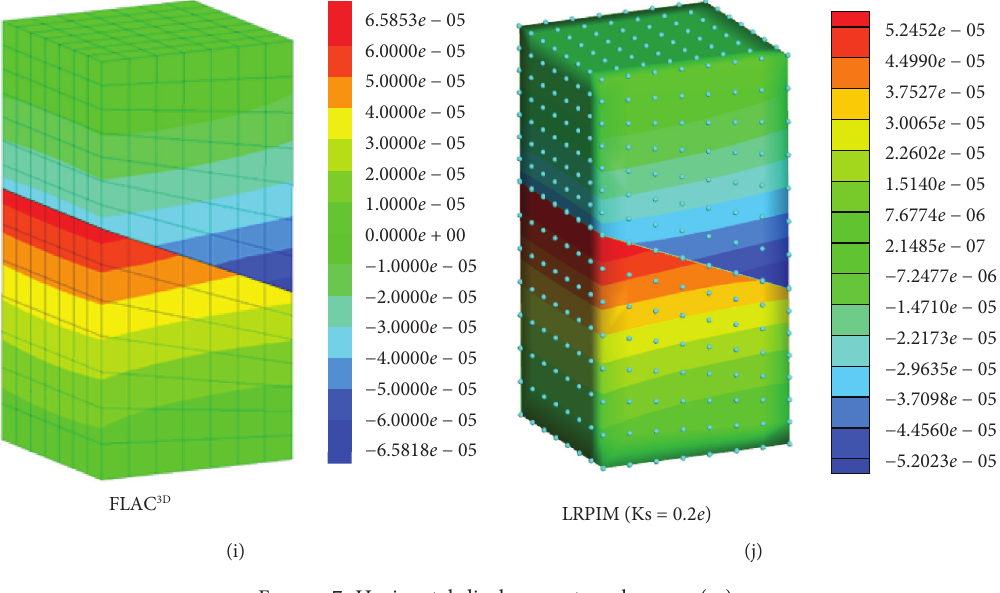
Figure 7: Horizontal displacement nephogram